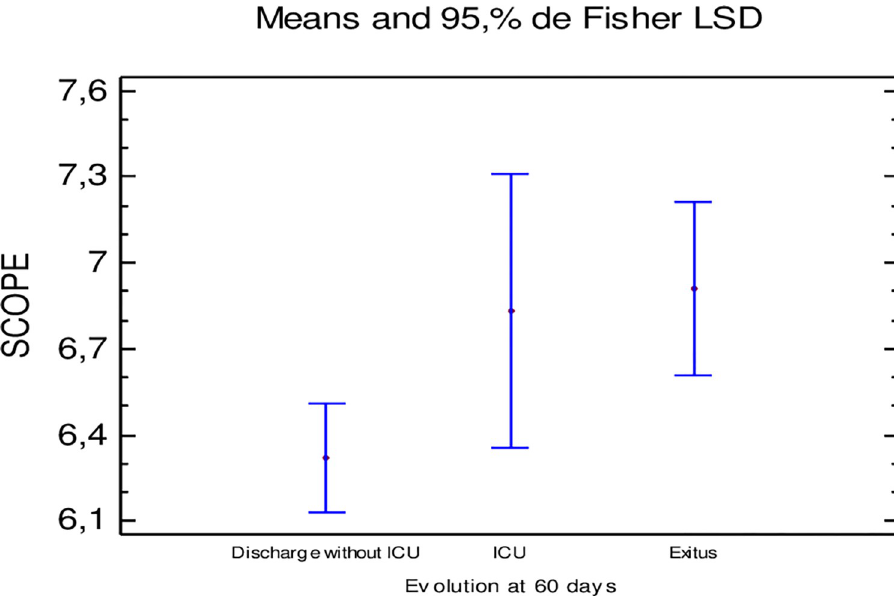
Fig 7. Relationship between a simplified SCOPE score at start of treatment with anakinra and clinical outcome at 60